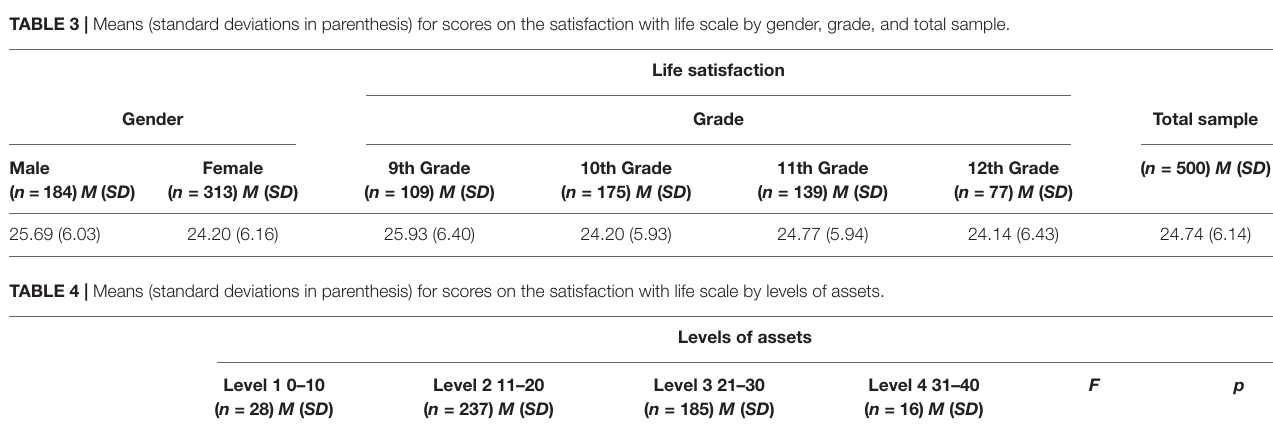
TABLE 3 | Means (standard deviations in parenthesis) for scores on the satisfaction with life scale by gender, grade, and total sample.